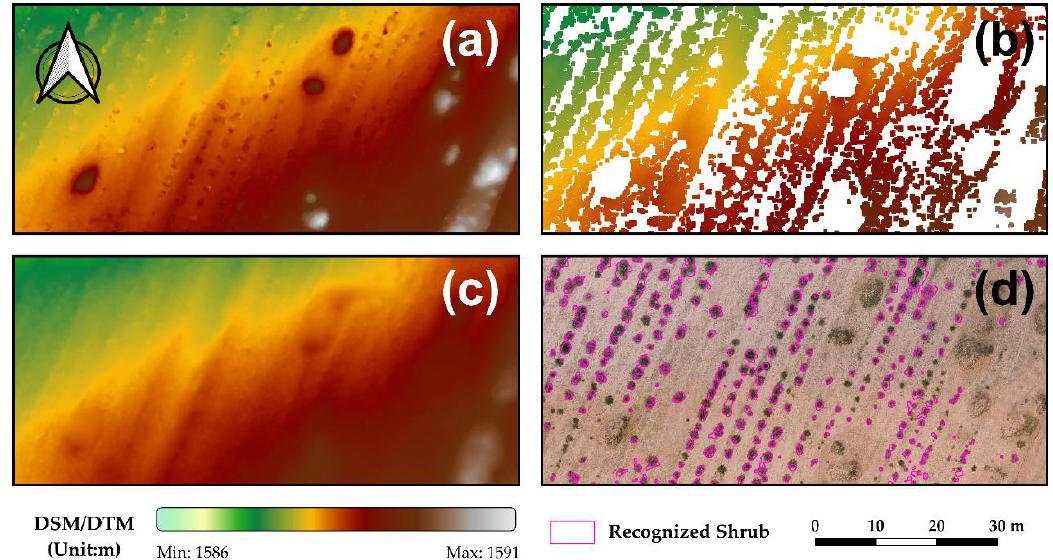
Figure 4. DSM-DTM based shrub identification approach: ( a ) DSM; ( b ) ground DTM; ( c ) fill DTM; ( d ) shrub area.